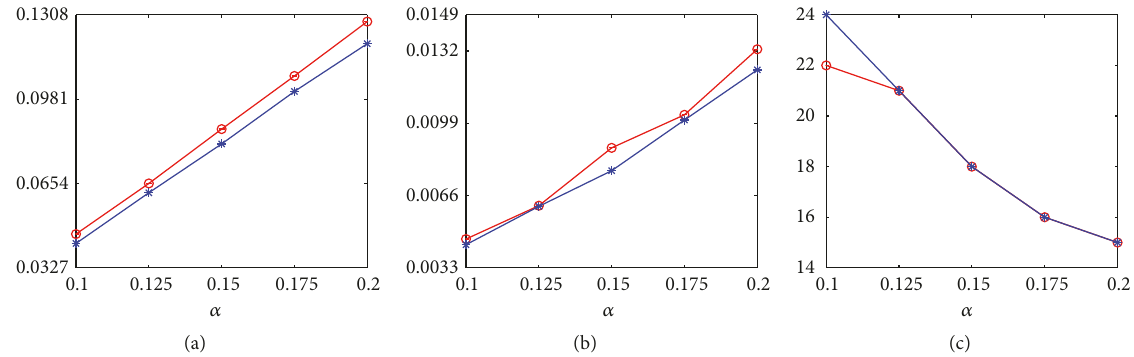
Figure 12: Comparison of three quantities of rumor propagation before and after deleting 12 nodes in PolBlogs: (a) the average propagation size, (b) the averagepeak prevalence,and (c) the arrival time of the averagepeak prevalence(red circles representthe situation before deleting and blue stars represent the situation after deleting).